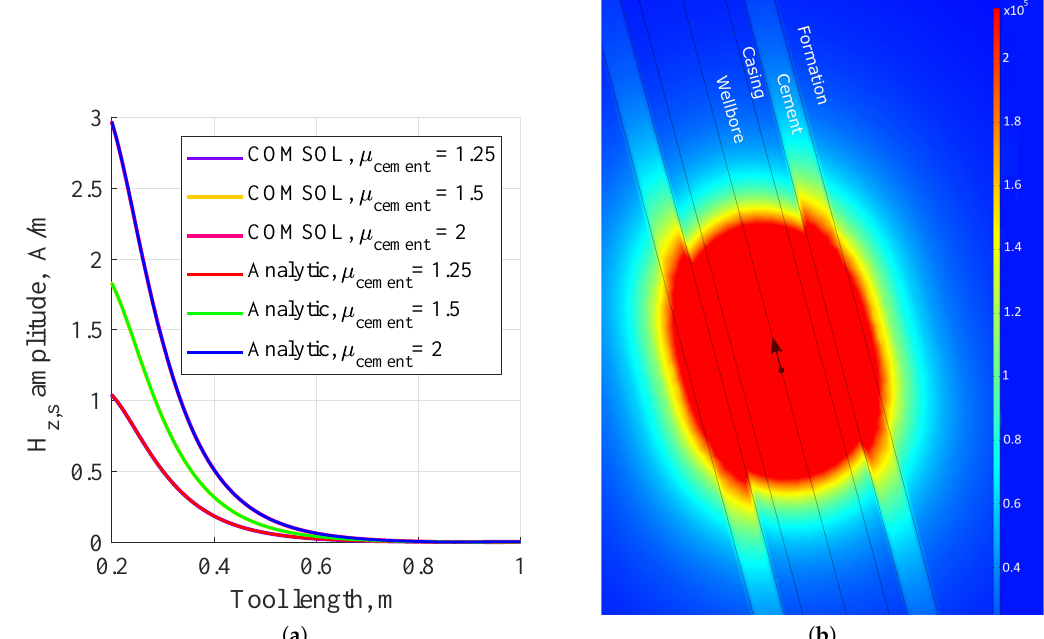
Figure 7. ( a ) Comparison of useful signal amplitude computed using COMSOL and analytic solution and ( b ) propagation of the magnetic field generated by a point dipole source in the wellbore at the frequency of 1 kHz